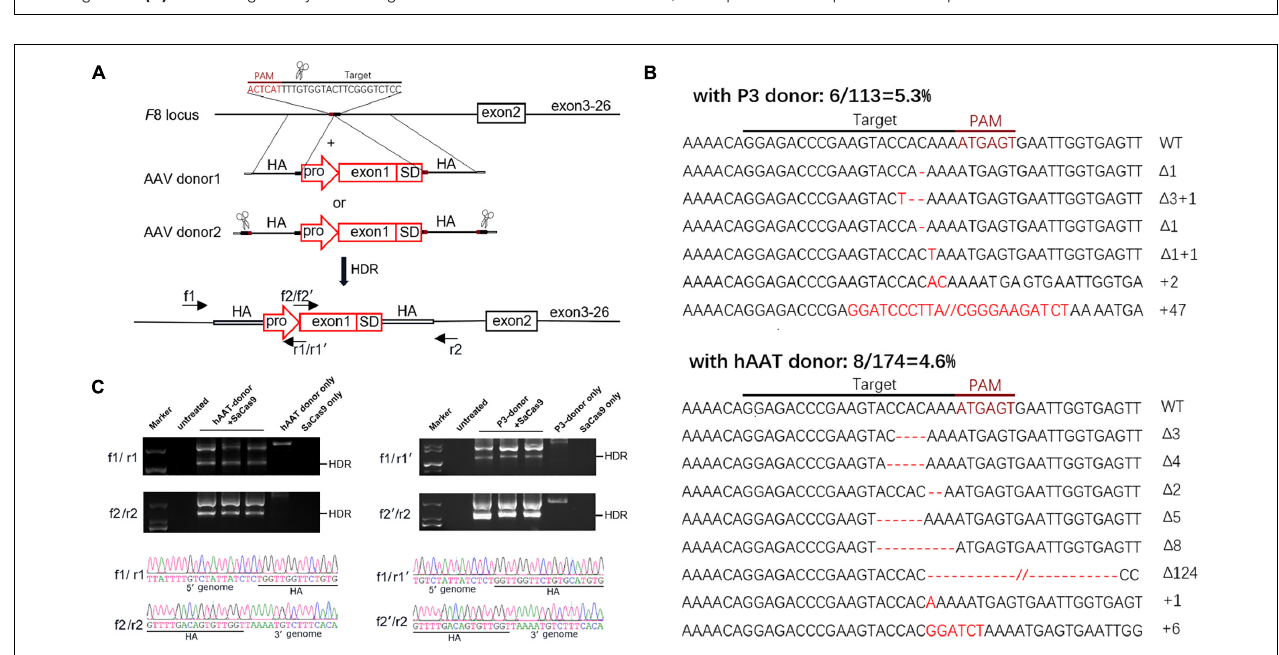
FIGURE 3 | Design and evaluation of the sgRNAs. (A) Schematic shows the location of the 6 sgRNAs targeting intron 1 of F8 . (B) Target sequences and PAMs of the 6 sgRNAs. (C) The cutting activity of each sgRNA was evaluated in B16-F10 cells, the experiment was performed in triplicate.